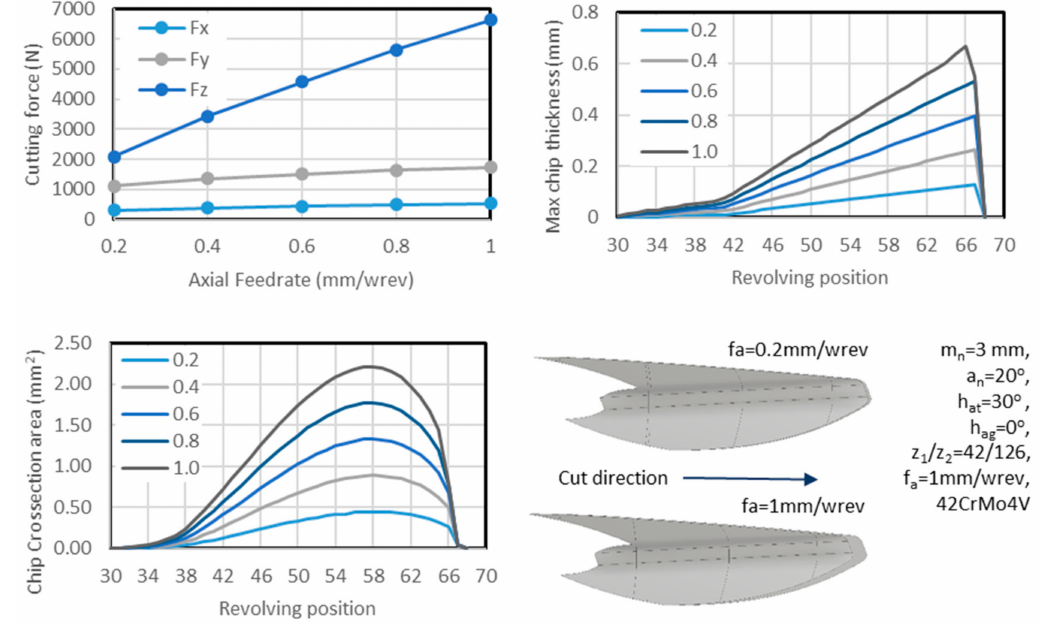
Figure 10. Effect of feedrate on cutting